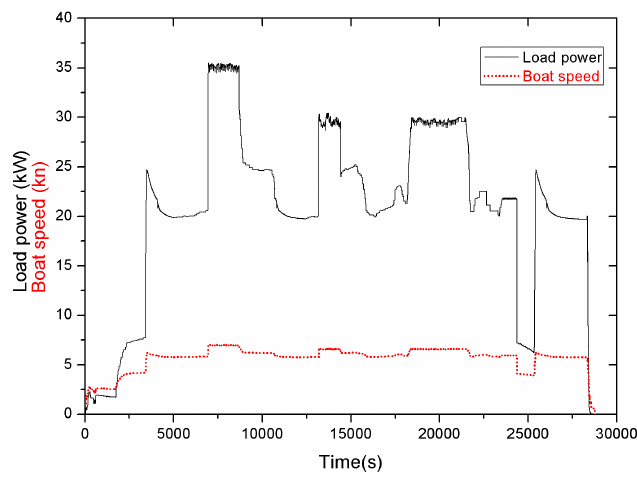
Figure 4. Load and speed profiles of the boat on the Suzhou River in variable-speed navigation. Table 6. 8 h navigation data of the boat for experimentation.